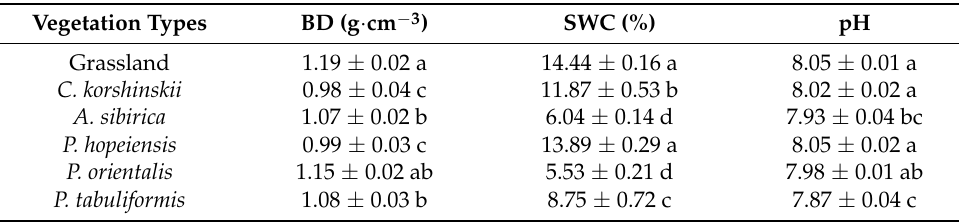
Table 2. Soil physical properties of six vegetation types in the study